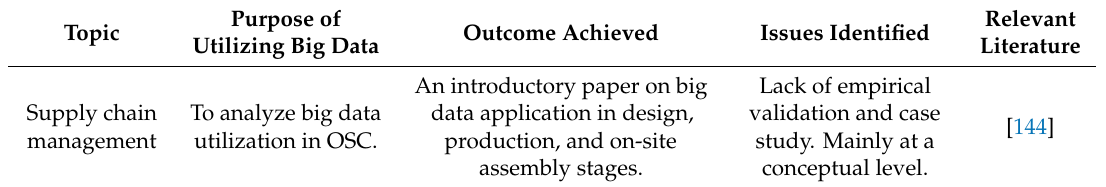
Table 17. Research topics, purpose of big data adoption, and outcomes achieved in previous studies. Topic